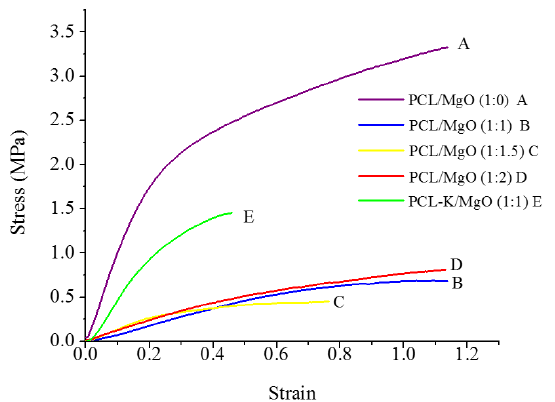
Figure 4. Representative stress-strain curves of PCL/MgO and PCL-K/MgO nanofibers, n =